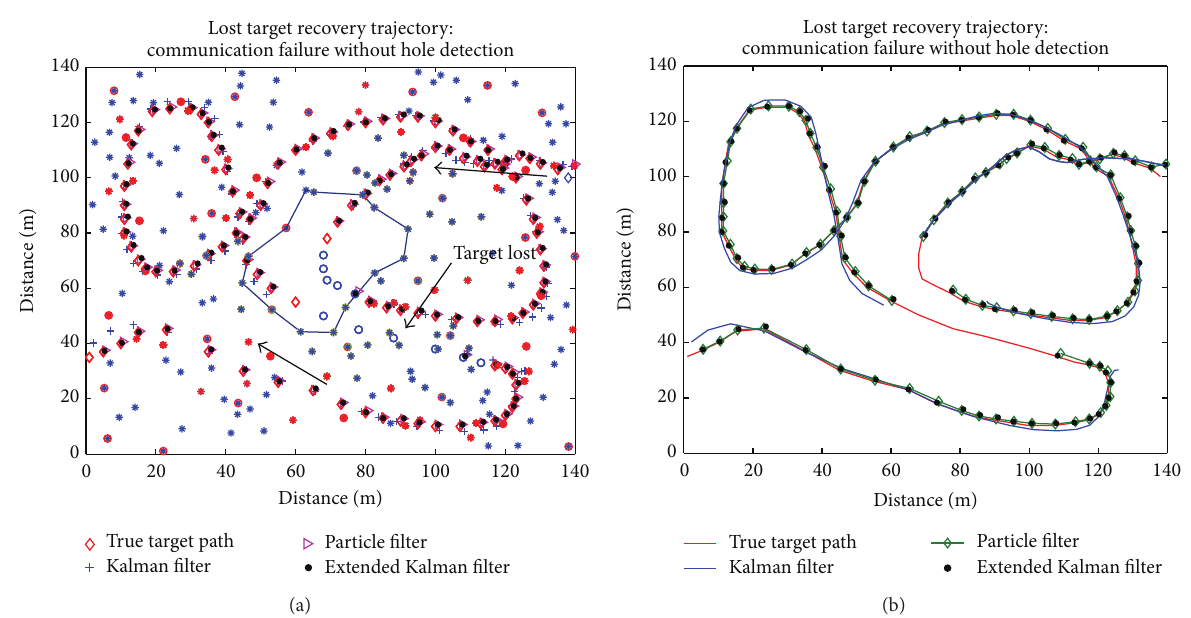
Figure 8: (a) Loss of target due to coverage hole in the WSHUN network trajectory. (b) Loss of target due to coverage hole in the WSHUN network graph.